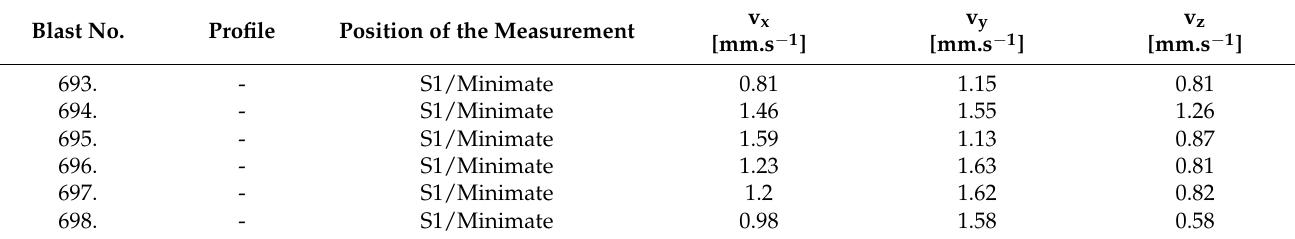
Figure 7. Measuring points S1 and S2 ([60], (source: author)). Table 5. Measured values of peak particle velocity in blasts (source: